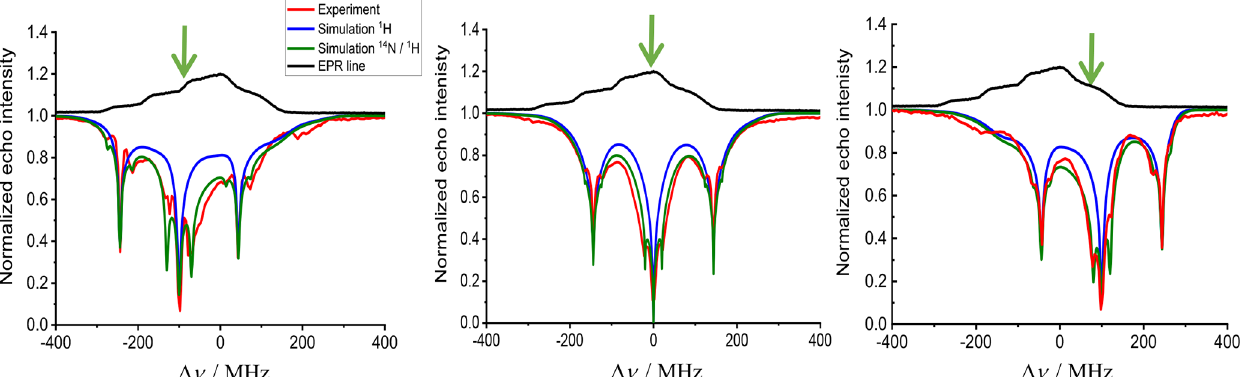
Figure 7. Experimental (red) and simulated (blue and green) ELDOR spectra of 10mM TEMPOL at different positions along the EPR spectrum (in black) measured at 20K. The green arrow indicates (cid:49)ν det . All spectra were fitted with (cid:51) eSD = 60µs − 3 , T 1e = 5 . 7ms and T 2MW = 100µs. The blue spectra show the result of the simulation including only the 1 H while the green spectra include both 1 H and 14 N SE contributions. The detection frequency is marked with a green arrow at the top of each panel. The simulation was performed using 350 frequency bins with a 2MHz width, spanning the whole EPR spectrum. The pump frequency spanned 1000MHz with steps of = 3 × 10 − 3 , A SE = 1 . 5 × 10 − 3 and A SE = 0 . 4 × 10 − 3 . The NMR frequencies 2MHz; the forbidden transition fitting parameters were A SE H N HN (corresponding the ν K in Eq. 12) used in the simulation were υ H_NMR = ± 144MHz, υ N_NMR = ± 20MHz for 14 N and υ HN_NMR = υ H ± 20MHz for the 1 H and 14 N